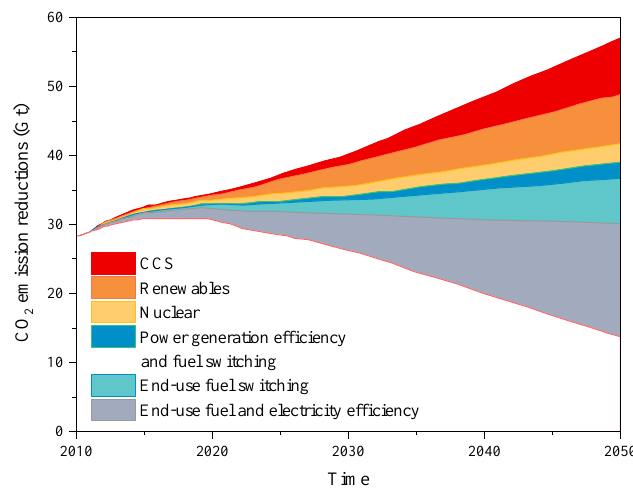
Figure 2. International Energy Agency (IEA) forecasts of key technologies for CO 2 emission reductions (modified from [8]).